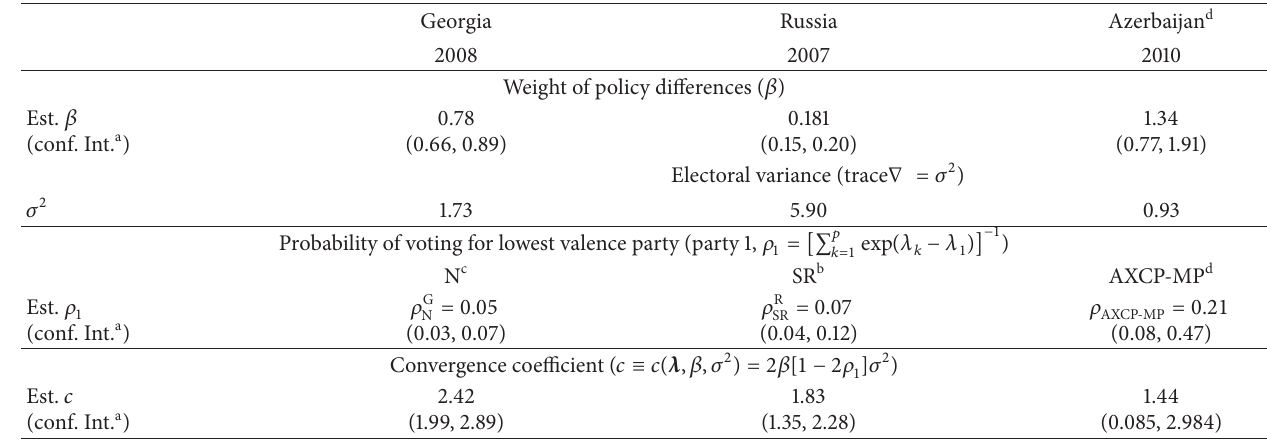
Table 6: The convergence coefficient in